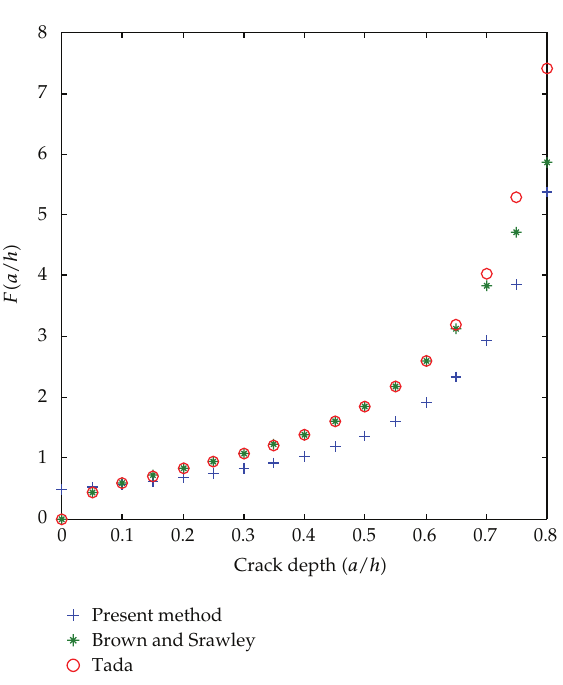
Figure 4: Stress intensity factor